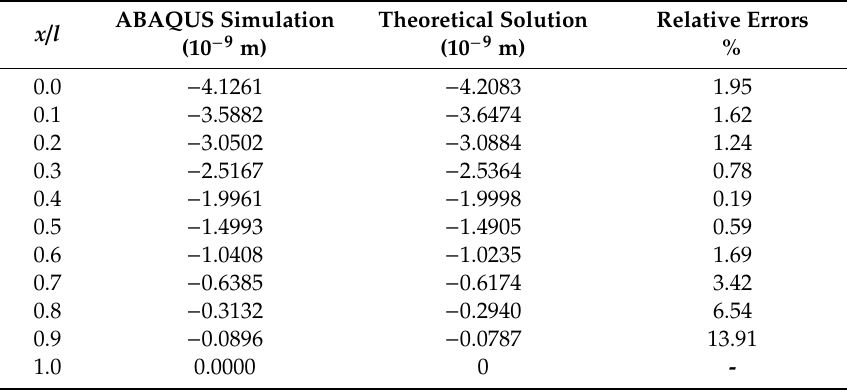
Table 3. Relative errors of two solutions of w ( x )